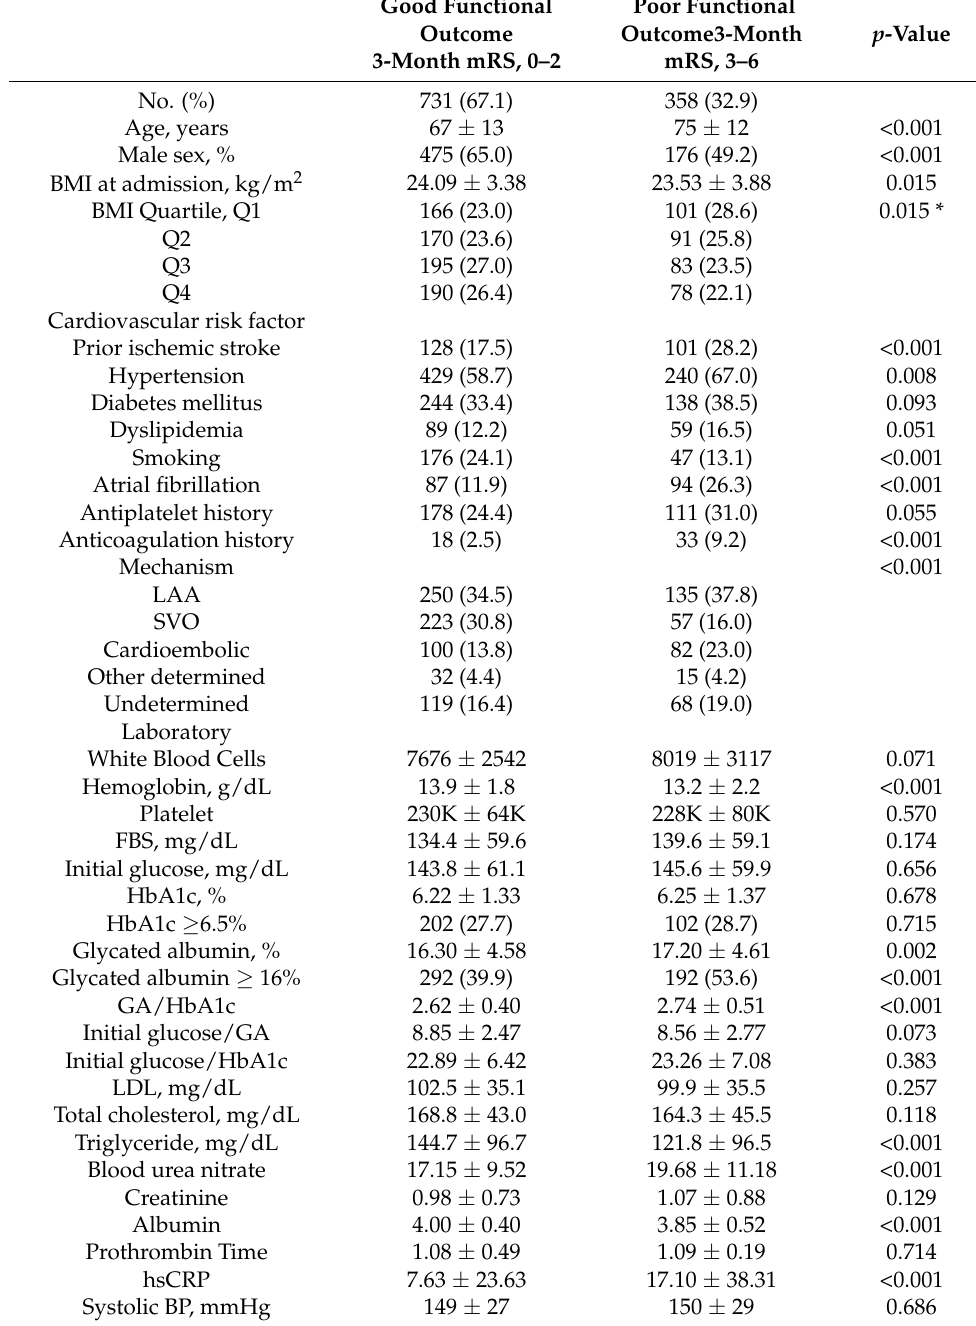
Table 2. Baseline characteristics according to short-term functional